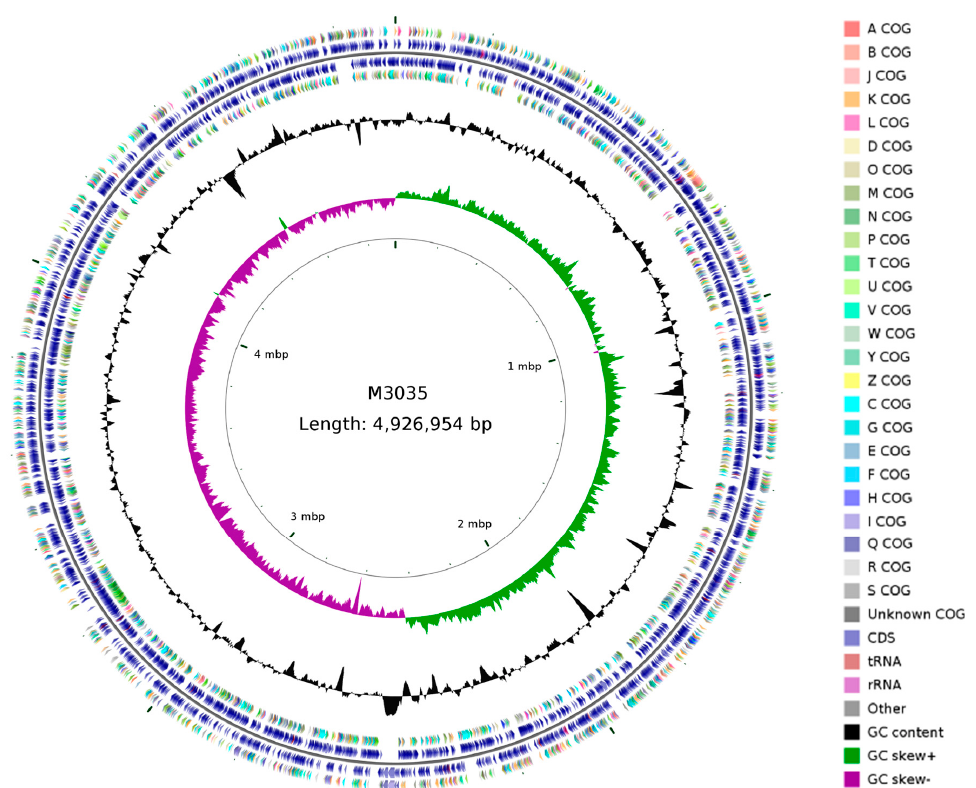
Figure 8. Circular representation of M30-35 genome. From the inner to outer circle: the first circle shows the scale; the second and third circles show G + C skew and G + C content, respectively; the fourth and seventh circle shows the distribution of genes related to COG categories; the fifth and sixth circle shows CDS, tRNA and rRNA on the location of the complete genome. A: RNA processing and modification; B: Chromatin structure and dynamics; J: Translation, ribosomal structure and